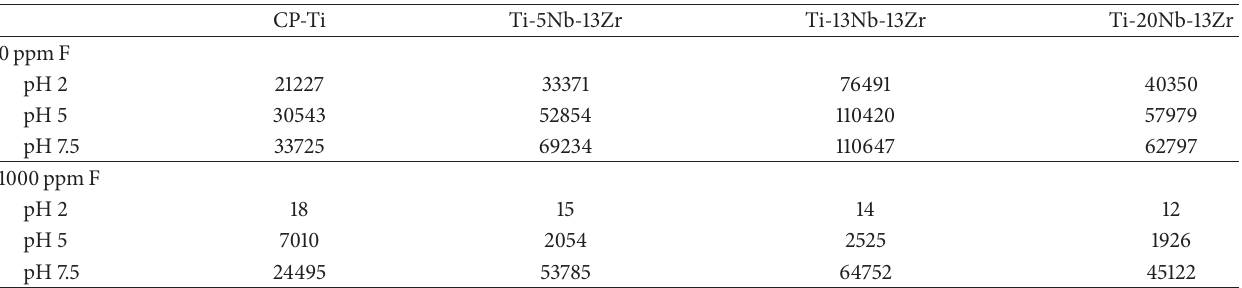
Figure 6: Polarization curves of (a) CP-Ti, (b) Ti-5Nb-13Zr, (c) Ti-13Nb-13Zr, and (d) Ti-20Nb-13Zr in Ringer’s solution of pH 2, 5, and 7.5 containing 1000ppm F at 37 ∘ C. Table 4: Impedance modulus (in Ω cm 2 ) at low frequency (= 0.1Hz) in Ringer’s solution of pH 2, 5, and 7.5 without fluorides and containing 1000ppmF at 37 ∘